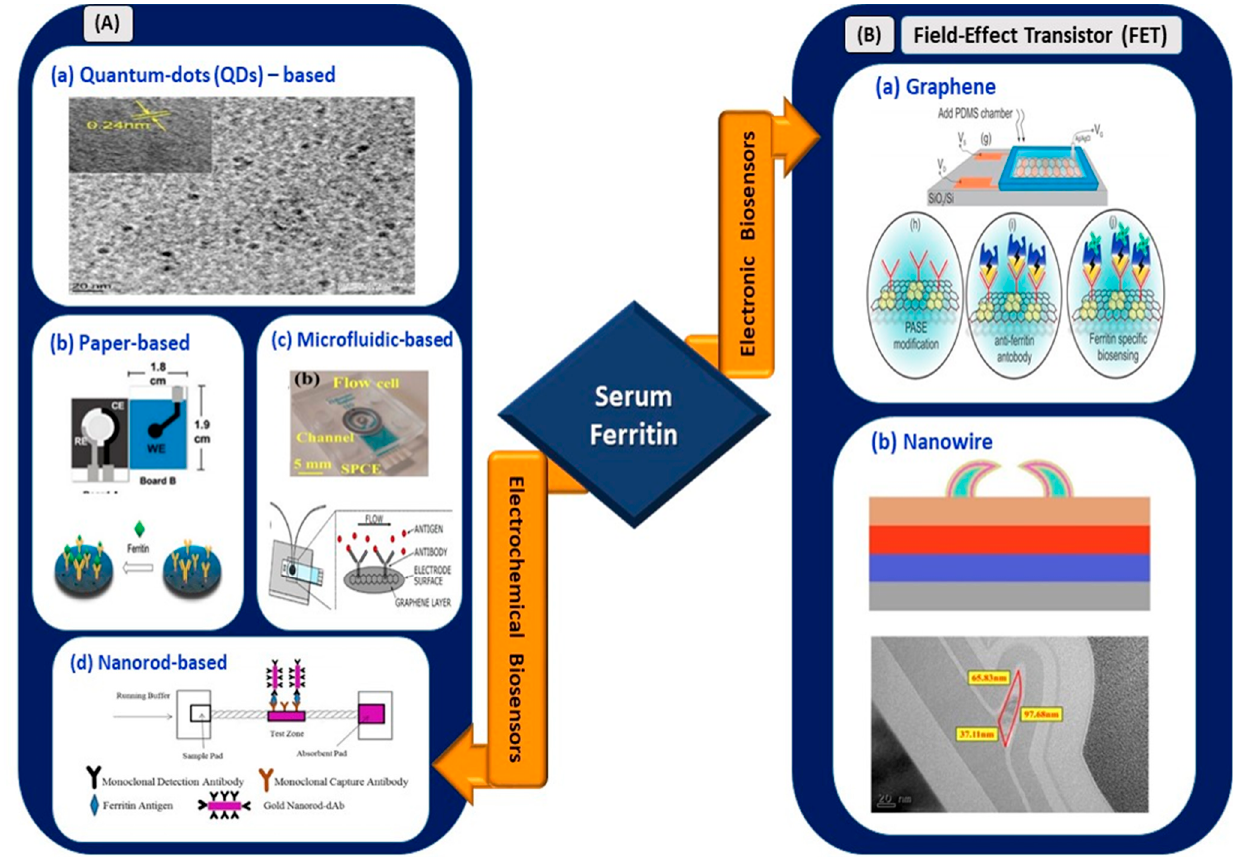
Figure 5. ( A ) Electrochemical biosensors: ( a ) tungsten disulfide quantum dots-based electrochemical detection of serum